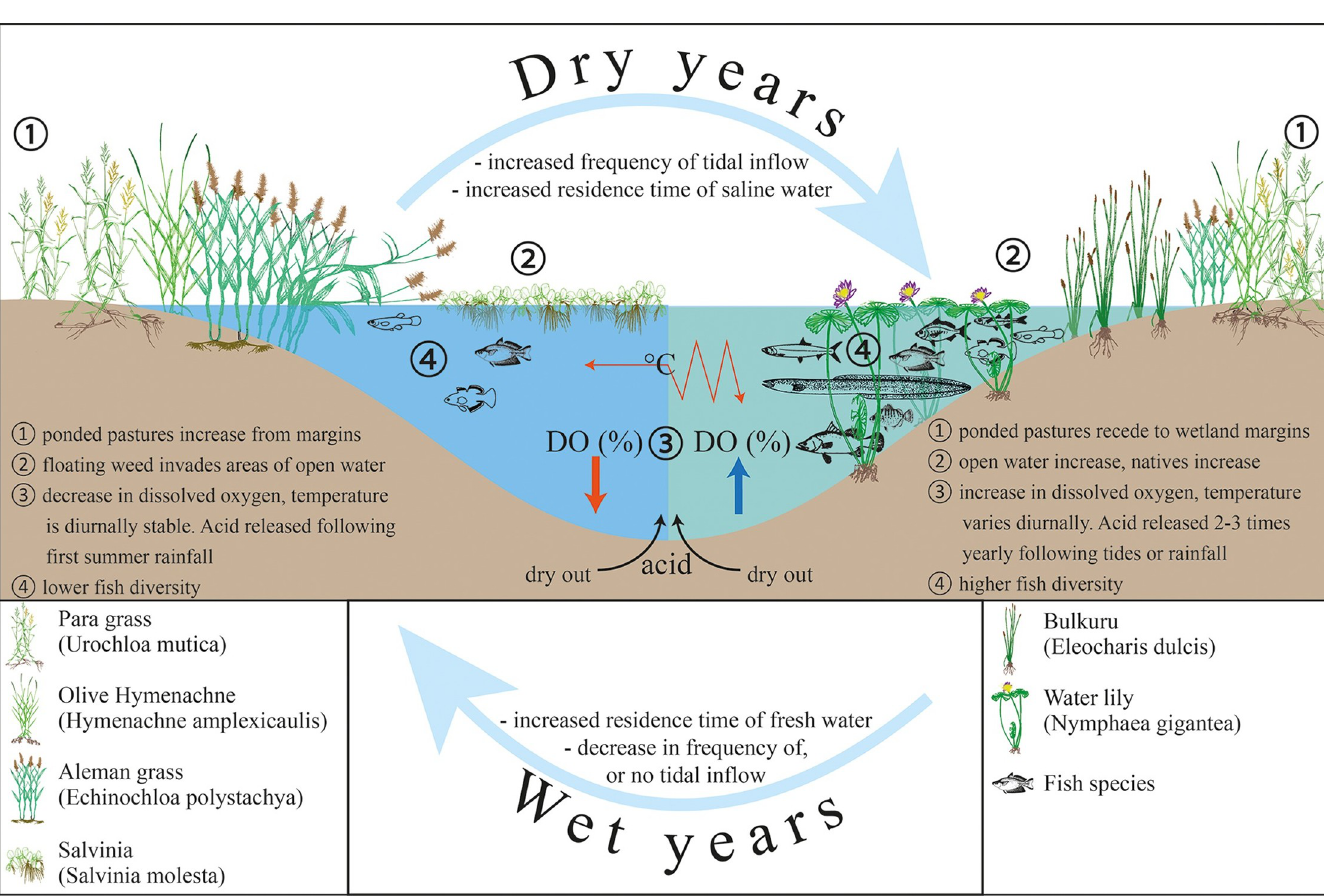
Fig 19. Conceptual model showing changes due to seasonal oscillations within the shallow Boolgooroo region of the Mungalla wetlands. This oscillation/cycle is likely to occur on other shallow wetlands if this method of passive remediation is employed.